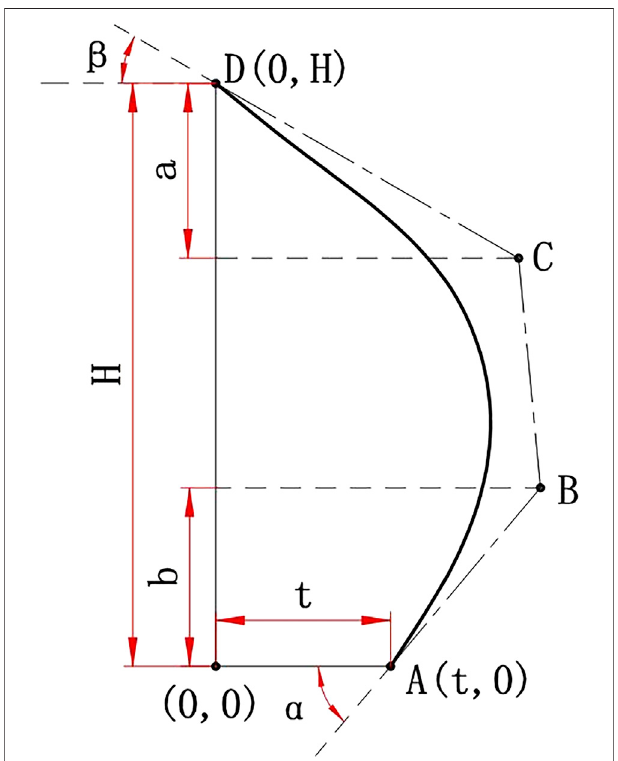
FIGURE 1 | Parametric representation of blade pro fi le.